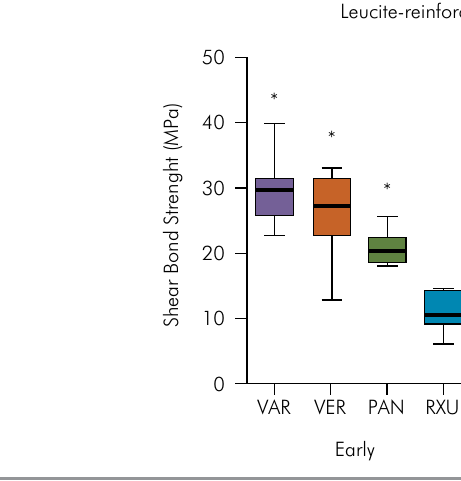
Figure 2. Boxplots of early and late shear bond strength of resin cements to leucite-reinforced feldspathic ceramic.